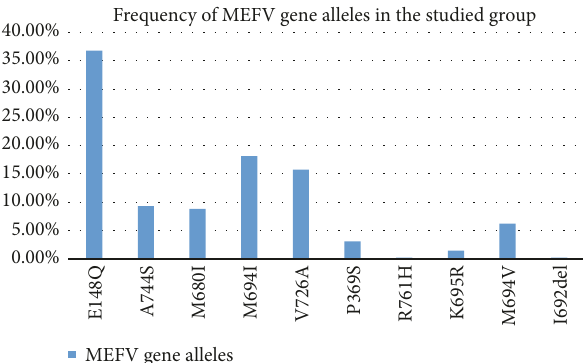
Figure 2: Frequency and spectrum of the common MEFV alleles in the studied